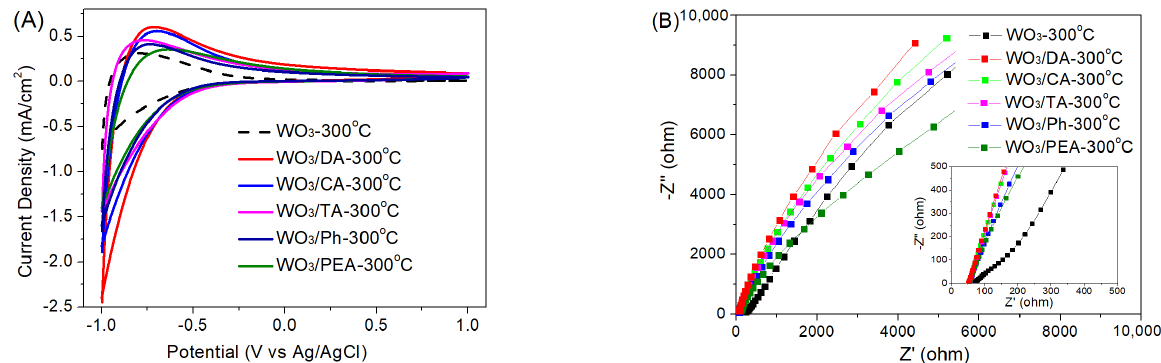
Figure 6. ( A ) CV curves tested at a scan rate of 100 mV s − 1 between − 1.0 and +1.0 V and ( B ) Nyquist plots of the WO 3 -300 °C, WO 3 /DA-300 °C, WO 3 /CA-300 °C, WO 3 /TA-300 °C, WO 3 /Ph-300 °C and WO 3 /PEA-300 °C fi lms in 1 mol/L LiClO 4 /PC at frequency from 100 kHz to 10 mHz using a perturbation amplitude of 10 mV at the potential of 0 V.